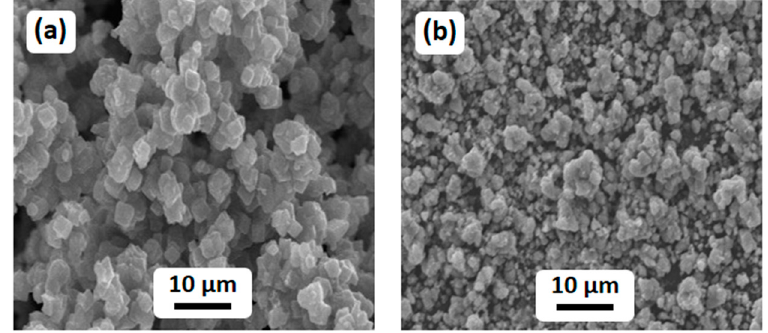
Figure 5. SEM analysis of ( a ) (1%)Ag 2 O–MnO 2 and ( b ) (1%)Ag 2 O–MnO 2 /(5 wt.%)GRO nanocomposite.